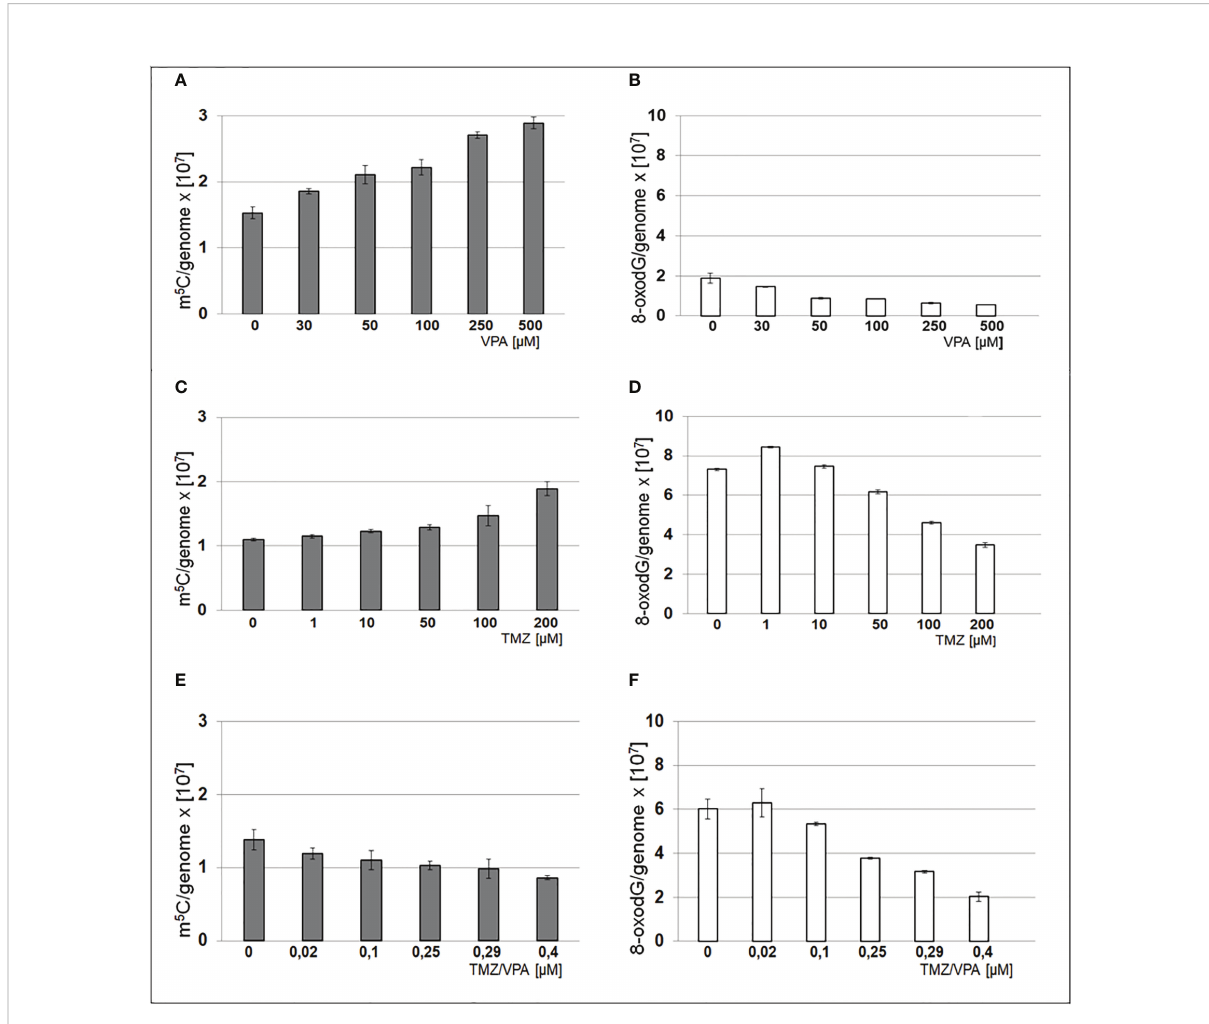
FIGURE 6 Contents of m 5 C – (A, C, E) and 8-oxo-dG – (B, D, F) in DNA from T98G cell line after treatment with TMZ, VPA or their mixture. The analysis was performed after 24 h of incubation in given TMZ (0, 1, 10, 50, 100 and 200 m M), and VPA (0, 30, 50, 100, 250, 500 m M) concentration and mixtures of both of TMZ/VPA at ratio (0, 0.02, 0.1, 0.25, 0.29, 0.4). In control experiment cells were treated with DMSO only. The R values are means from three